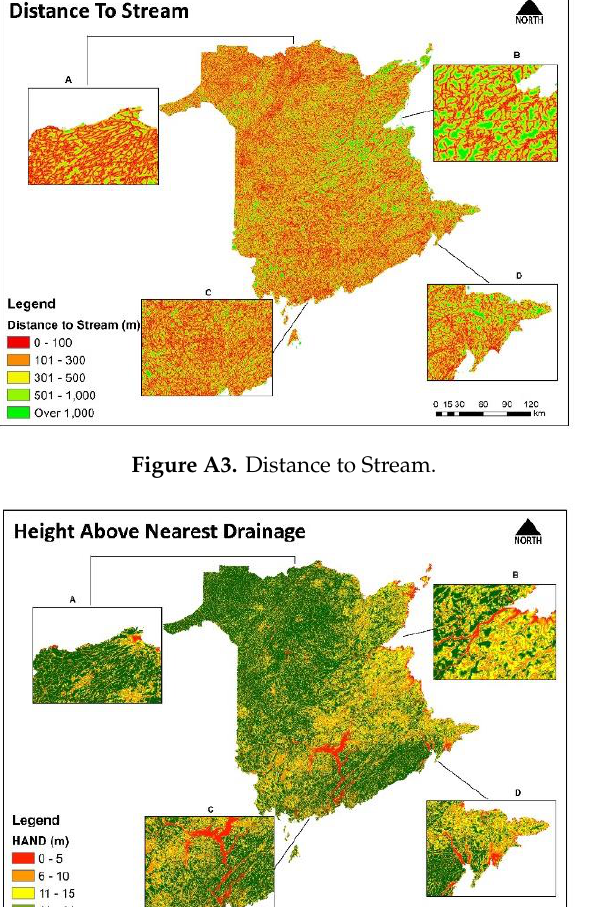
Figure A2. Total Rainfall.